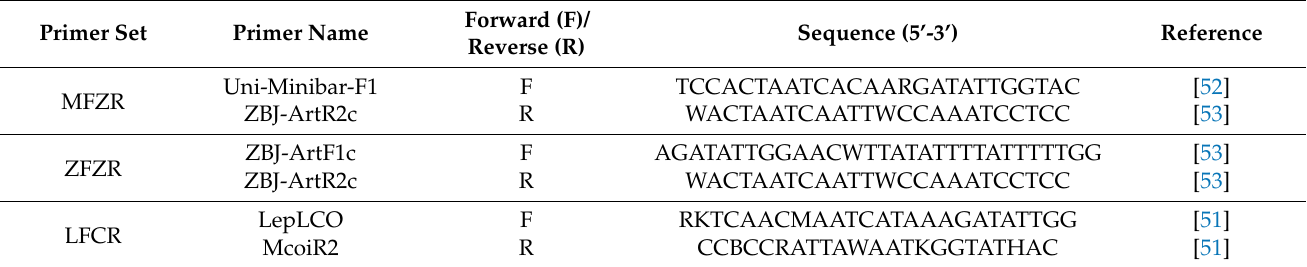
Table 2. Details of primer sets used in this